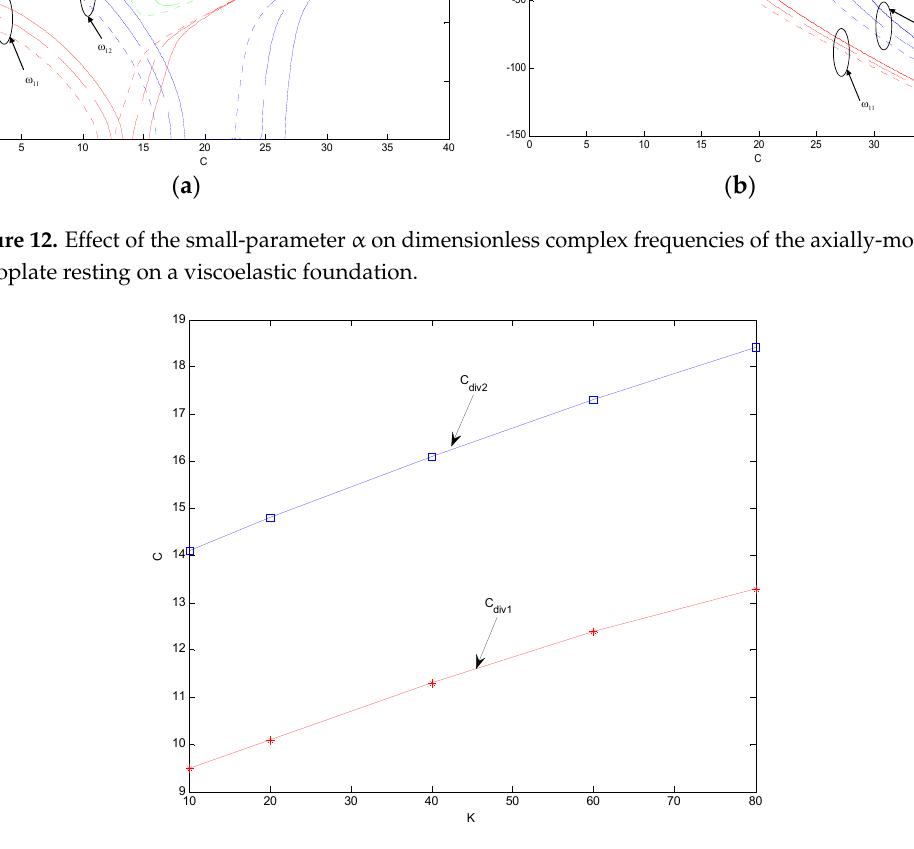
Figure 13. Effect of the axis force K on the divergence speed of the axially-moving nanoplate resting on a viscoelastic foundation.